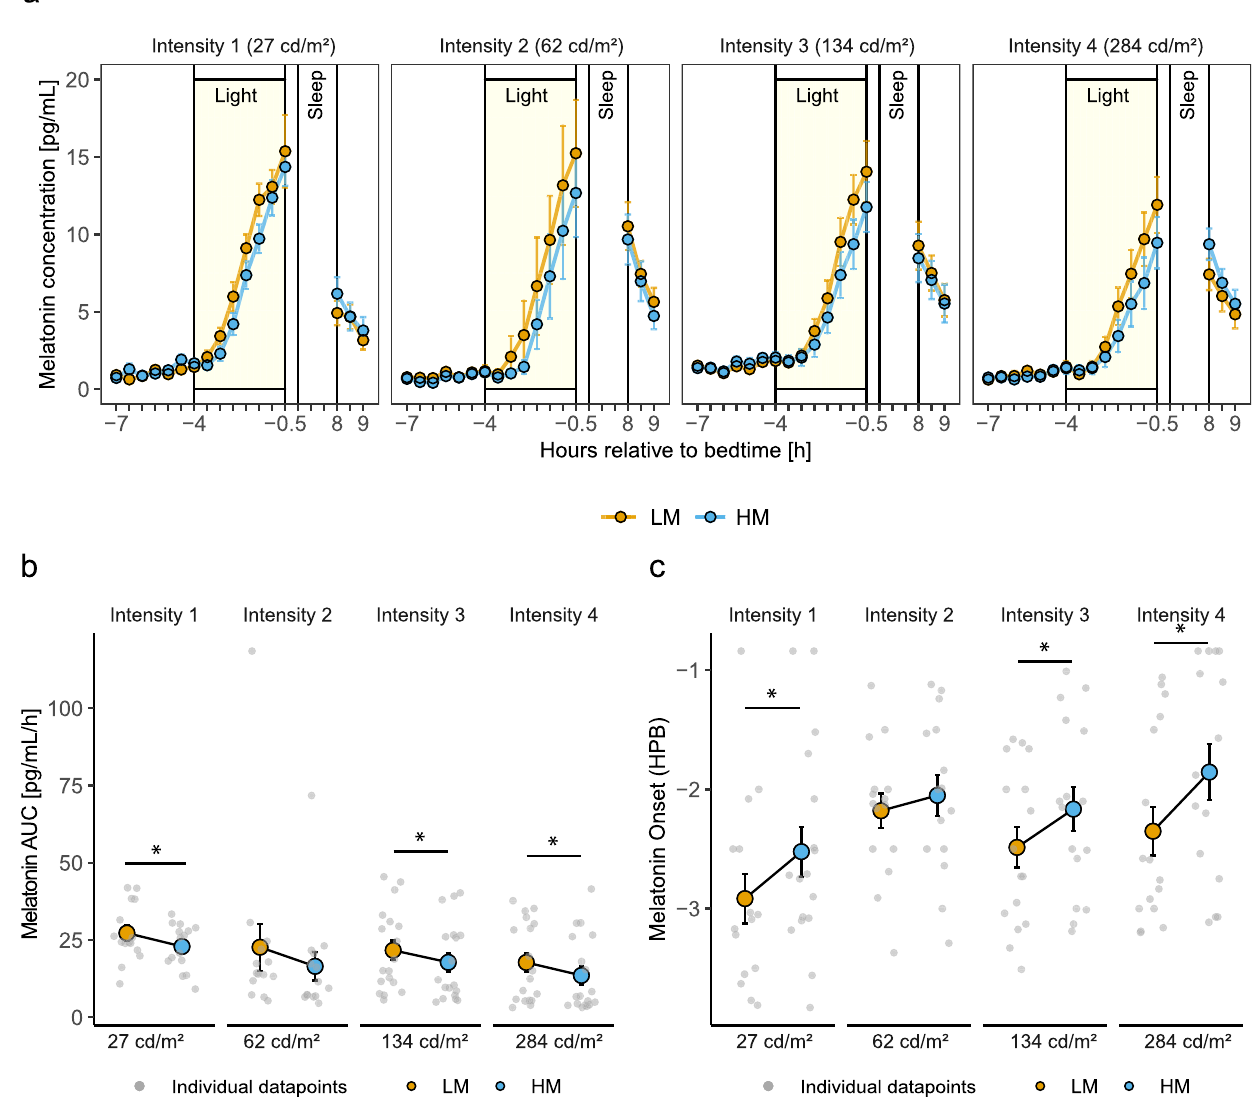
Fig. 3 Results for melatonin during light exposure. a Time course of salivary melatonin concentrations in pg/mL during the low melanopic (LM: orange points and lines) and high melanopic (HM: blue points and lines) light conditions plotted against the hours relative to bedtime [h]. Depicted are means ± 1SEM of the four light intensity groups (Intensity 1: n = 15, intensity 2: n = 14, intensity 3: n = 18, intensity 4: n = 18). In total, data of seven participants were not included in the data analysis due to low melatonin concentrations during the evening (for details see “ Methods ” section) b Melatonin AUC (area under the curve) in pg/mL/h during light exposure. Depicted are the means ± 1SEM for LM (Mean: orange points; SEM: black lines) and HM (Mean: blue points; SEM: black lines). (Intensity 1: n = 15, intensity 2: n = 14, intensity 3: n = 18, intensity 4: n = 18) c Melatonin onset relative to bedtime (HPB: Hours prior bedtime) during LM (Mean: orange points; SEM: black lines) and HM (Mean: blue points; SEM: black lines). Depicted are means ± 1SEM (Intensity 1: LM n = 15, HM n = 17; intensity 2: LM n = 15, HM n = 15; intensity 3: LM n = 16, HM n = 16; intensity 4: LM n = 16, HM n = 15). Grey points represent the individual values of participants. The black asterisks indicate the statistically signi fi cant main effect ( p < 0.05) of the fi xed factor light condition, computed in a linear mixed